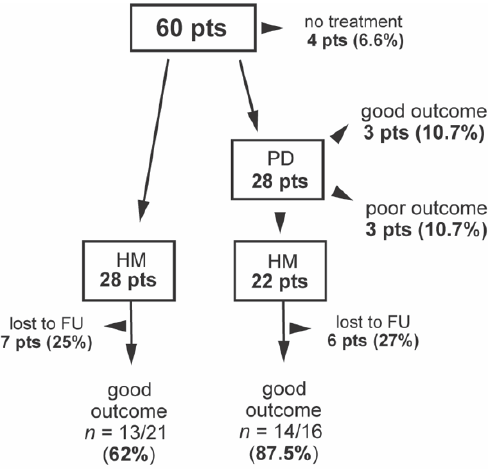
Figure 1. Outcomes of treatment. HM—Heller myotomy, NT—no treatment, PD—pneumatic dilatation, lost to FU—lost to follow up, pts—patients. Table 4. Comparison of clinical variables between patients with good and poor outcome of